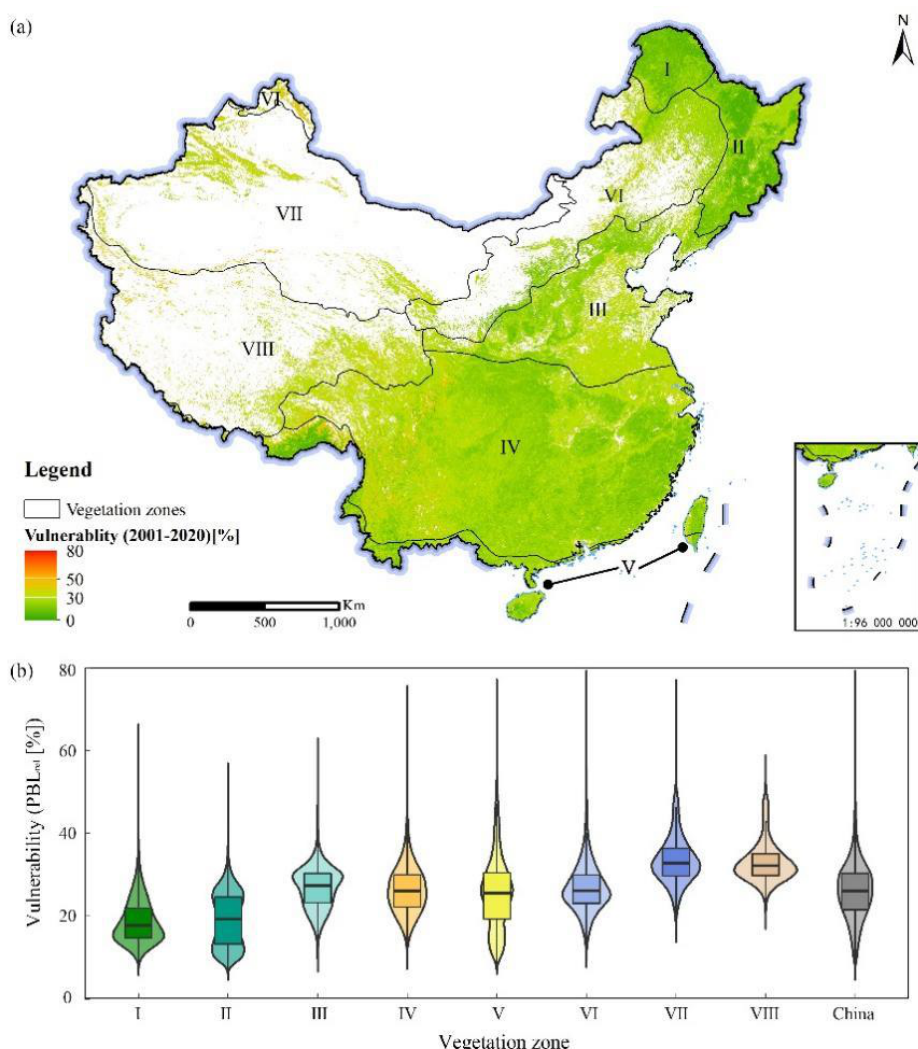
Figure 4. The average potential vulnerability of Chinese forests to fire disturbances from 2001 to 2020. ( a ) Spatial map of the average potential vulnerability. ( b ) Violin and box plots of average potential vulnerability within each vegetation zone. For each box plot, the centerline indicates the median value, the box limits indicate the upper and lower quartiles, and the whisker length is 1.5 × the interquartile range.